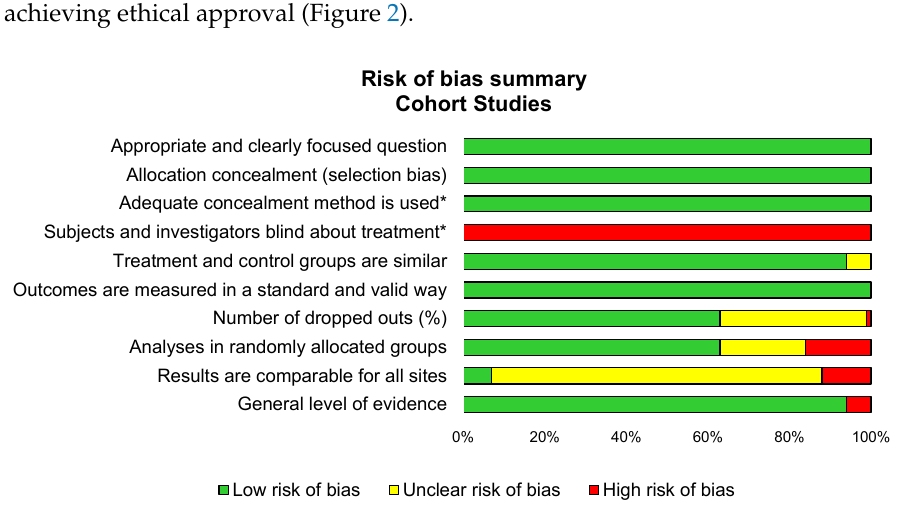
Figure 2. Summary of methodological qualities of included studies using the SIGN checklist.